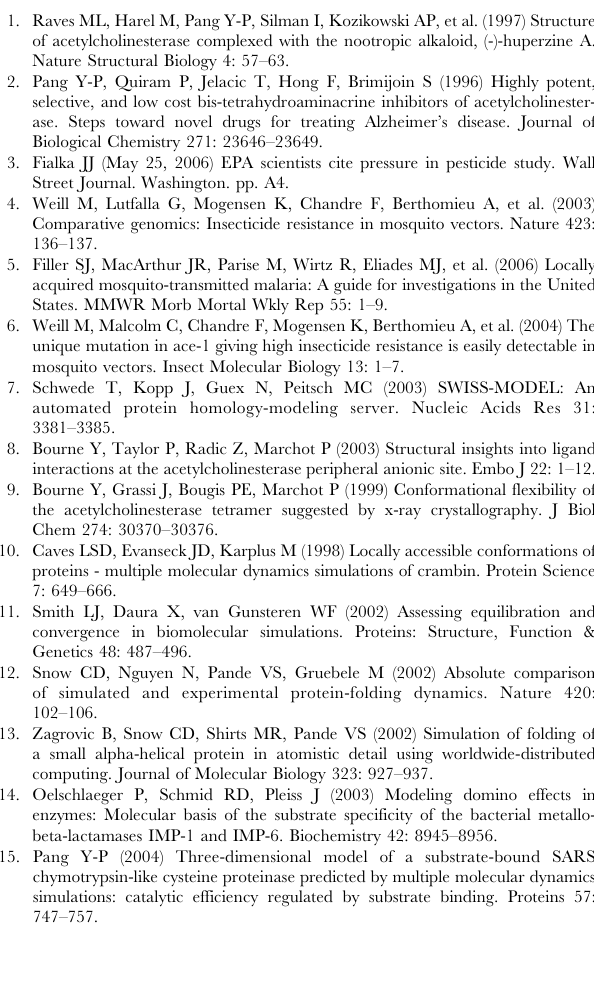
Table S1 Amber Atom Types and Charges of Acetylcholine